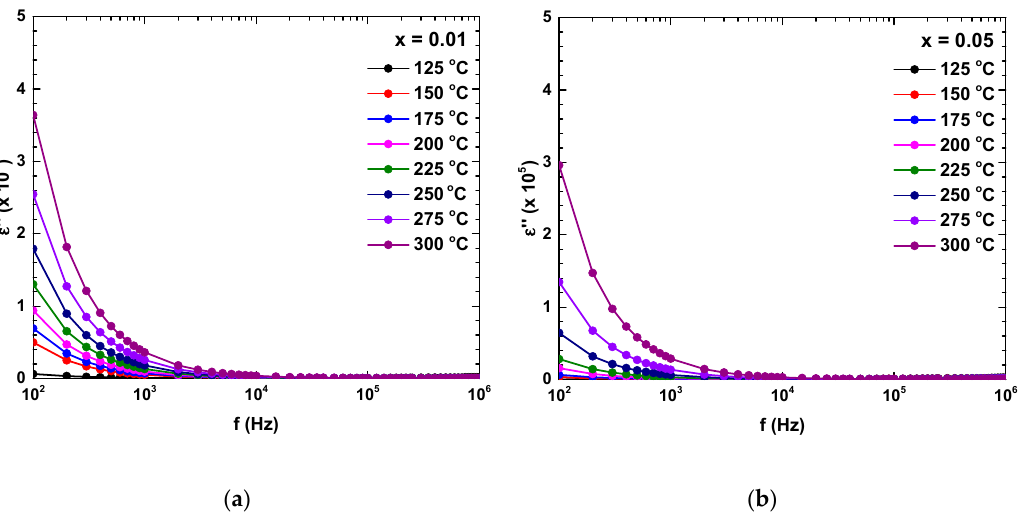
Figure 8. Dielectric loss, ε ”(f), of LaFe 1 − x Zr x O 3 with ( a ) x = 0.01 and ( b ) x = 0.05 annealed at 800 ◦ C for 6 h at different temperatures.